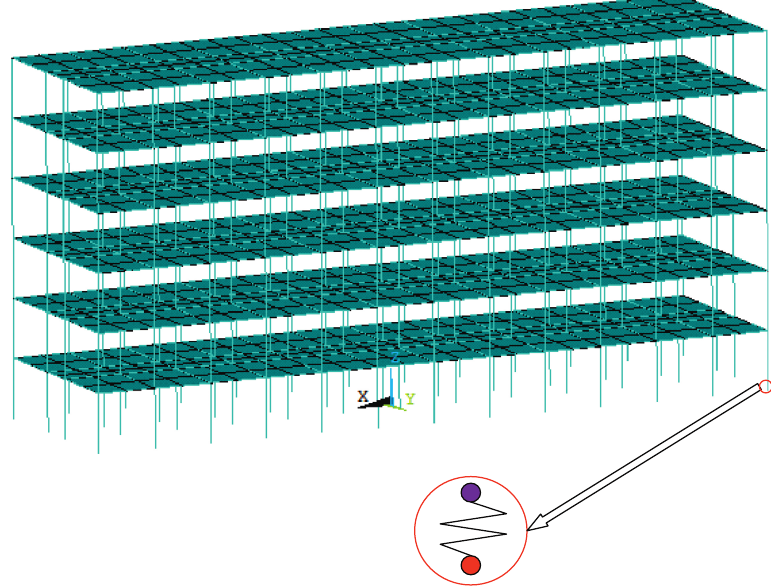
Figure 5: Three-dimensional finite element model of the